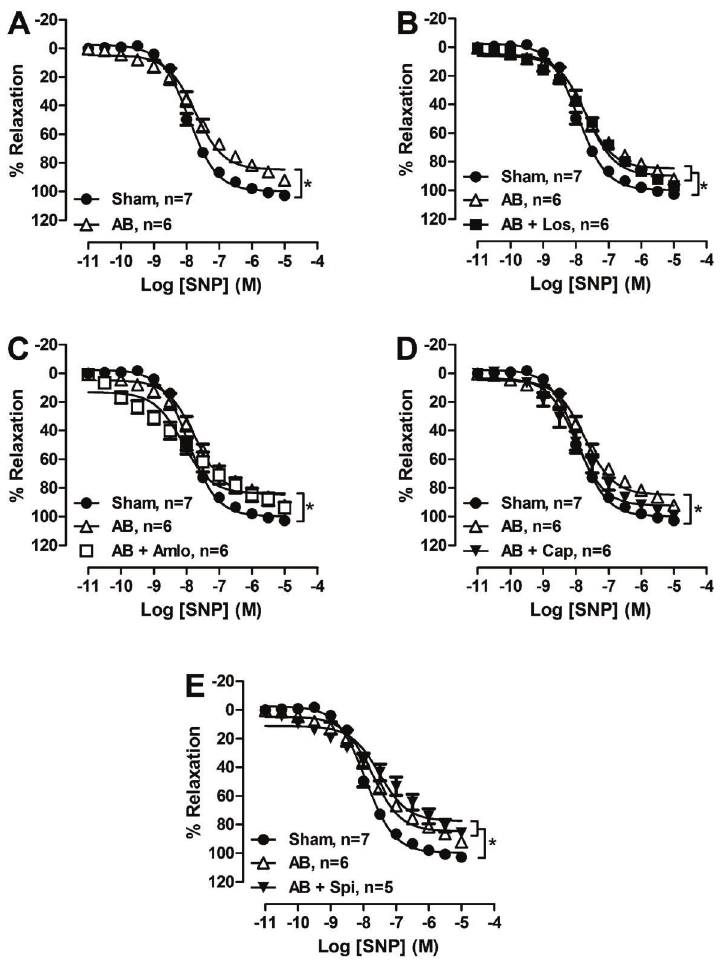
Figure 3. A , Effect of sodium nitroprusside (SNP) on the vasorelaxation in aortic rings from aortic banding (AB). Effect of chronic treatment with ( B ) losartan, ( C ) amlodipine, ( D ) captopril, or ( E) spironolactone (5 mg/kg of body weight per day) in response to SNP in aortic rings without endothelium from AB rats. Data are reported as means ± SE. Los: losartan; Amlo: amlodipine; Cap: captopril; Spi: spironolactone. *P o 0.05, two-way ANOVA followed by Sidak multiple com- parison